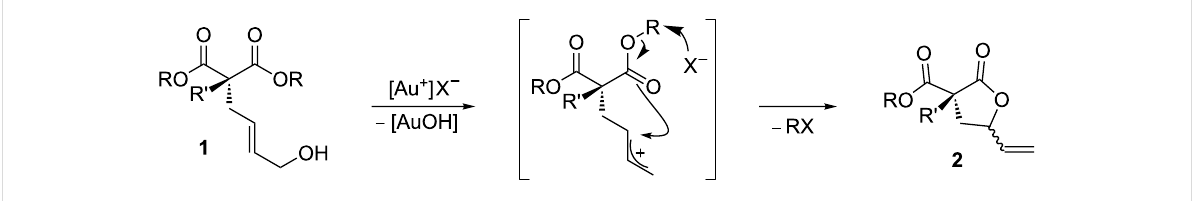
Figure 1: Working hypothesis for the present gold-catalyzed oxaallylic alkylation reaction.